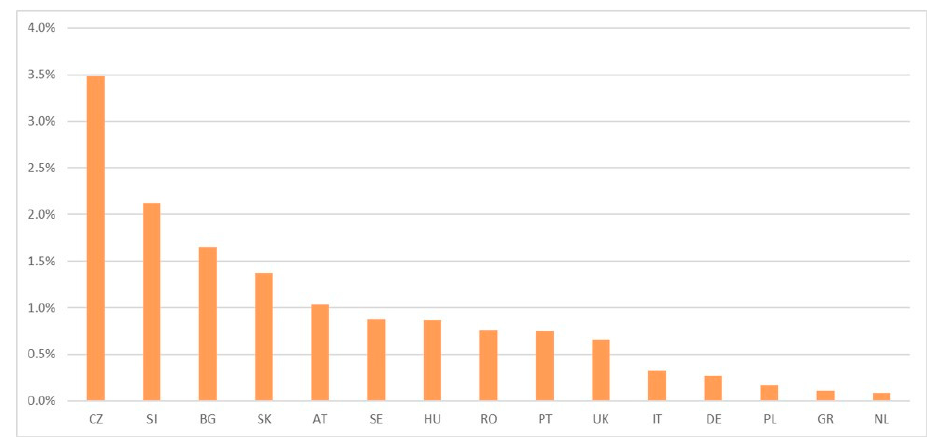
Figure 4. Share of CLLD allocation of EMFF by country, 2014–2020 [7].